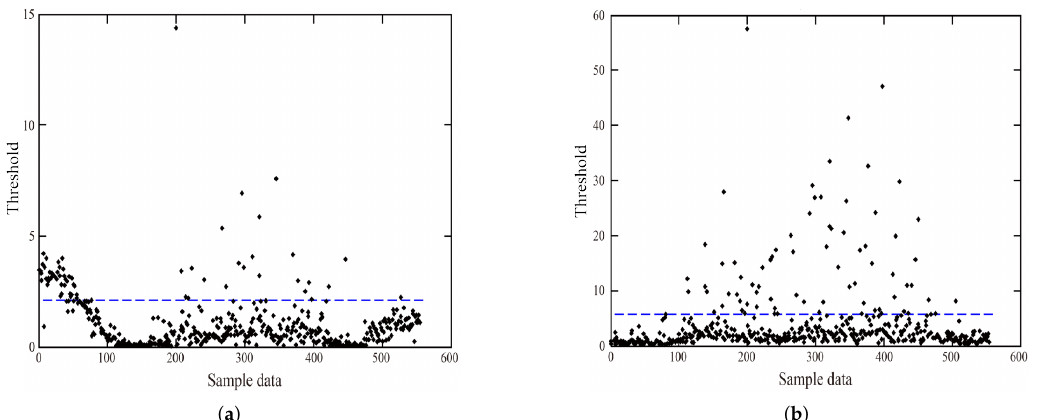
Figure 8. Control limit chart of the PCA (Principal Component Analysis) fault recognition model: ( a ) PCA- T 2 ; ( b ) PCA-SPE.